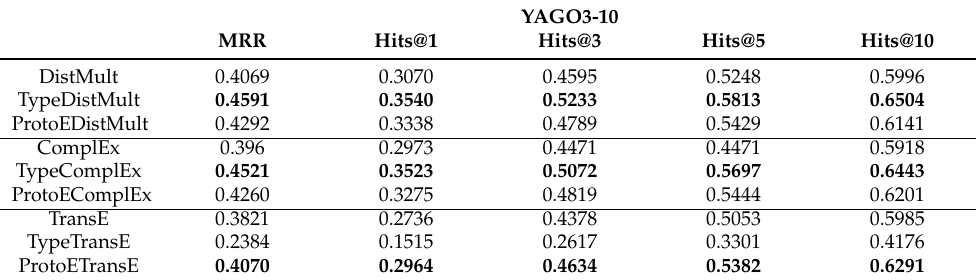
Table 4. Experimental results for YAGO3-10. Best values are indicated in bold.